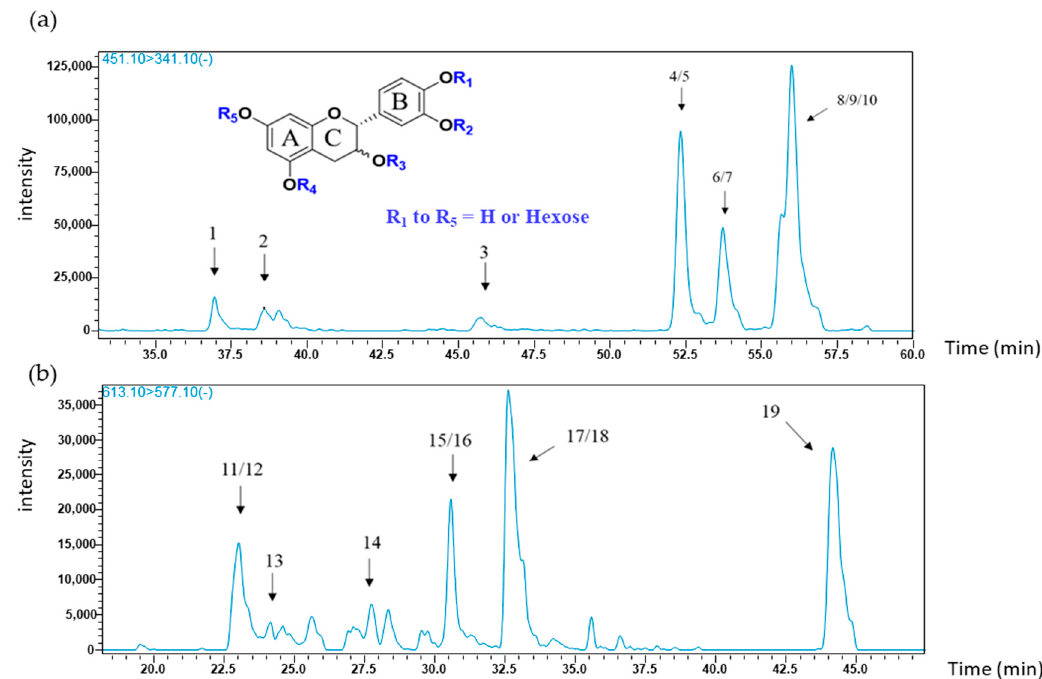
Figure 1. MRM profiles from the UHPLC-MS analysis of ( a ) (epi) catechin glycosides {451 → 341} and ( b ) (epi) catechin diglycosides {613 → 577} of a grape seed extract (Tannat, 25 July).